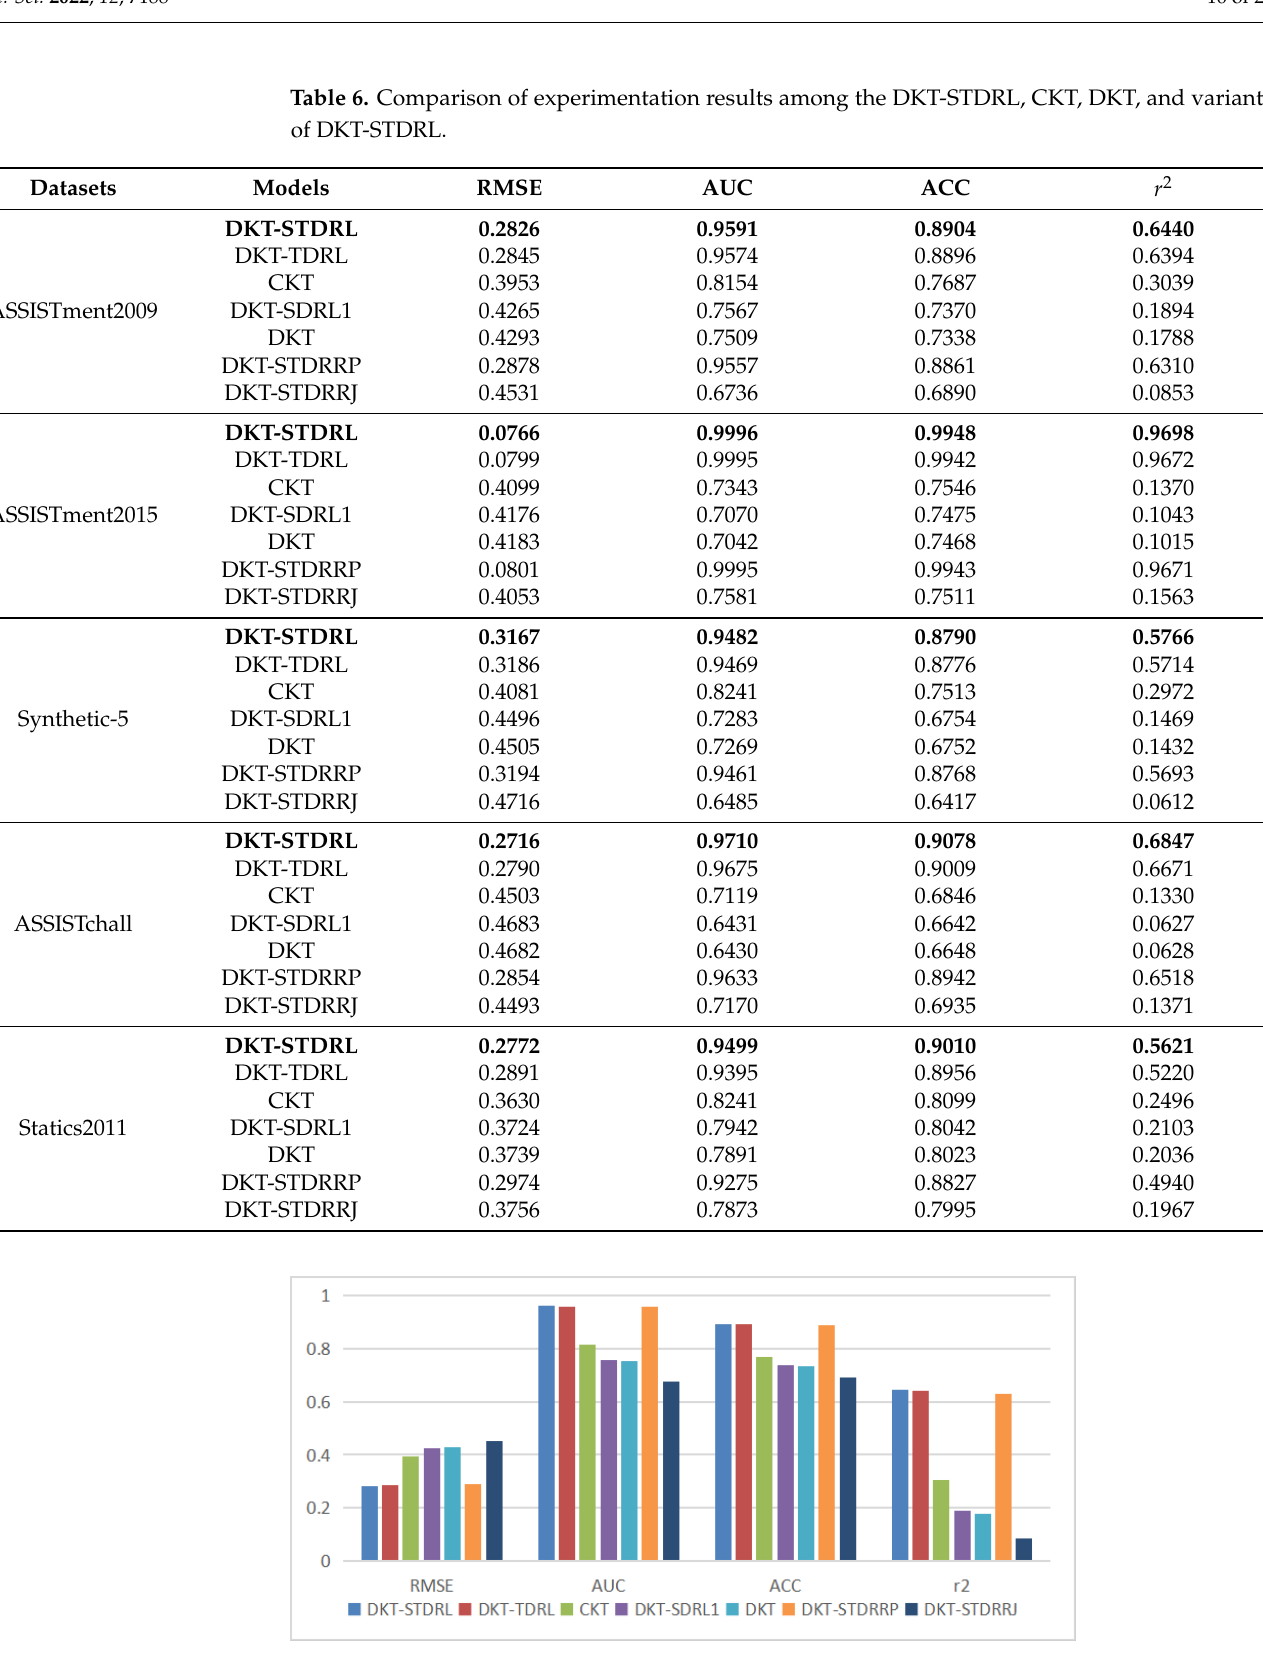
Figure 3. Prediction results of DKT-STDRL, CKT, DKT, and the variants of DKT-STDRL on the ASSISTments2009